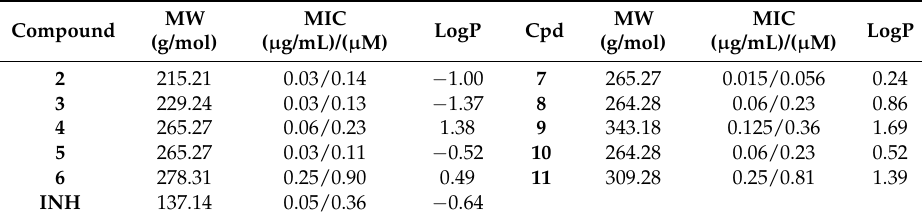
Table 8. MICs of Isoniazid-Nitrogen heterocyclic hydrazones against M.tb H37Rv.